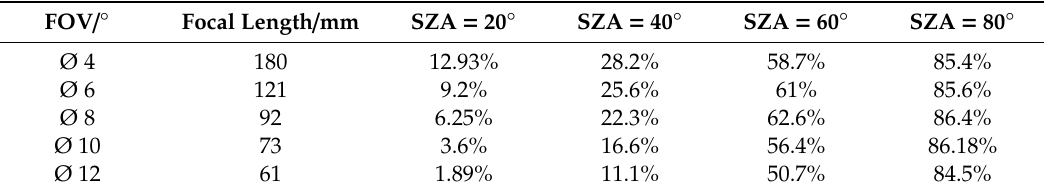
Table 2. Comparison of detection capabilities for di ff erent FOVs of star